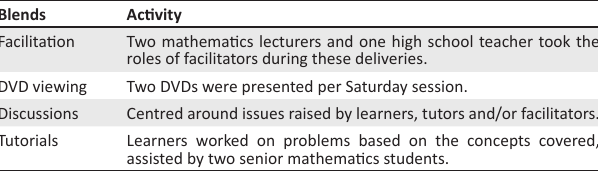
TABLE 1: List of blends.